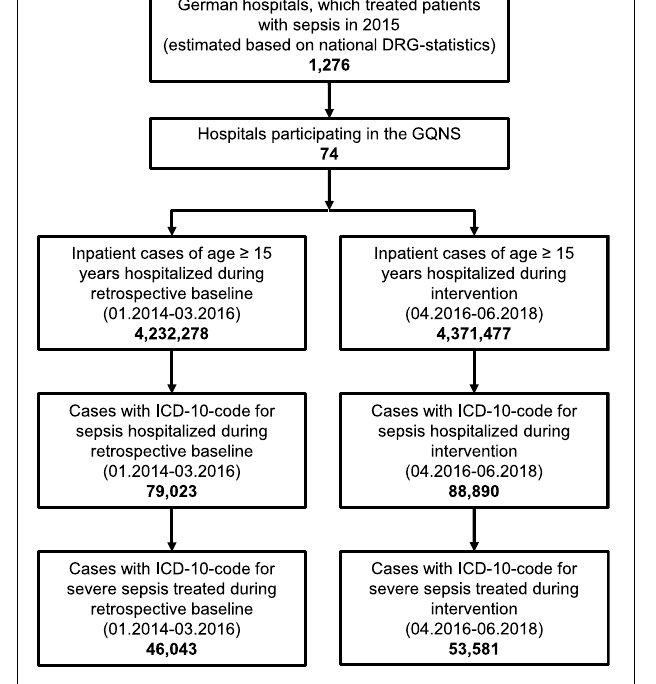
FIGURE 1 | Study flow chart.